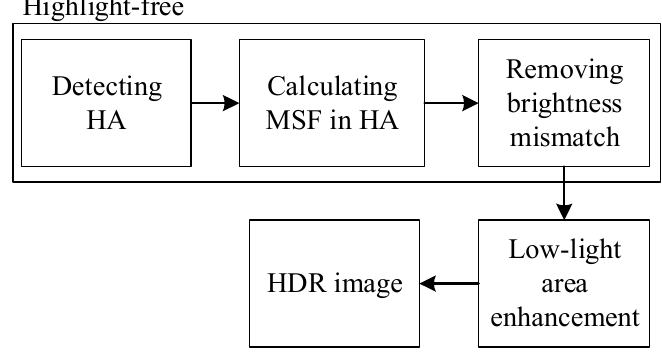
Figure 2. Proposed LDR to HDR generation algorithm.